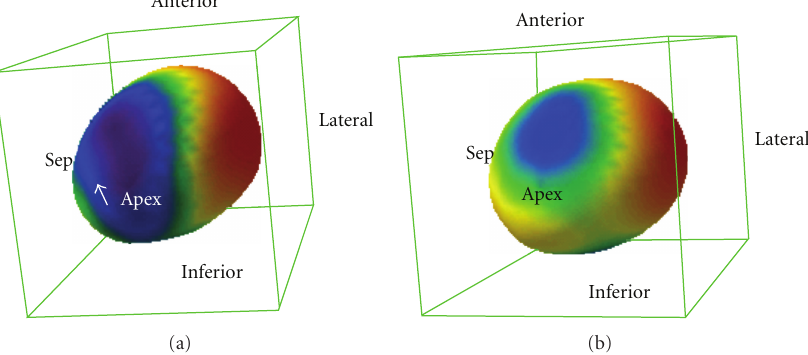
Figure 1: (a) MAGNUM Clinical Trial: Ischemic heart disease patient, 3D representation of the preoperative radioisotopic SPECT Tc 99m sestamibi imaging, showing the chronic infarction area (blue stain). (b) Same patient, followup at 18 months showing the improvement of myocardial viability and function (60% of reduction of the infarcted area, in blue) after stem cell therapy associated with the implantation onto the infarct scar of a cell-seeded collagen